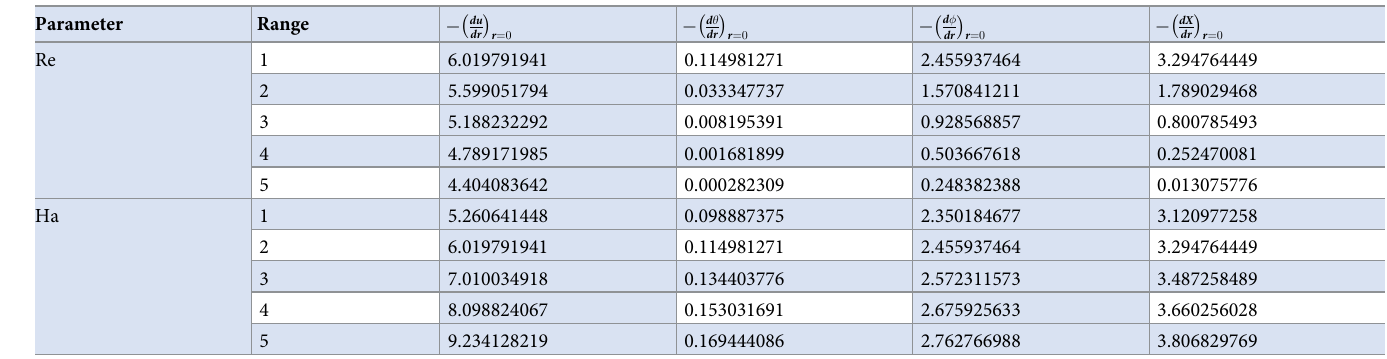
Table 1. Variations of quantities of physical interest for the changes in Re and Ha . Parameter Range